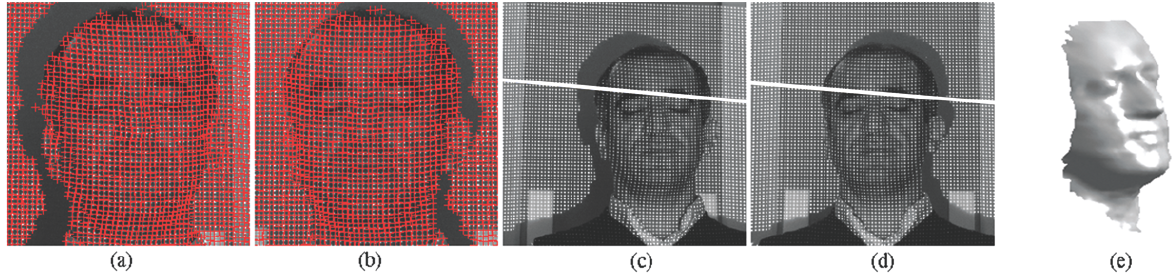
Figure 2. Experiments using the author’s face: (a)-(b)Harris points on stereo images, (c)- (d)The stereo images with an epipolar line, (e) 3D solid mesh model of the author’s face.